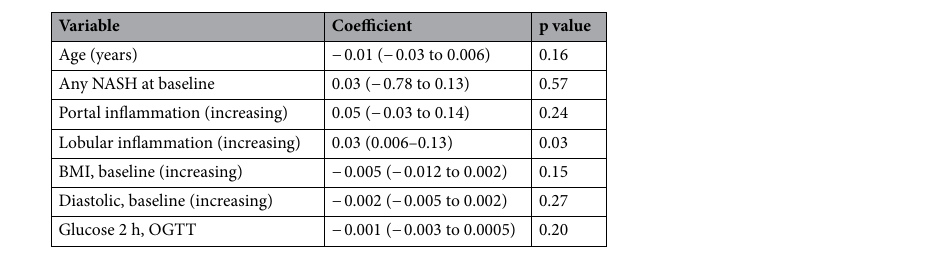
Table 5. Predictors of leukocyte telomere length at